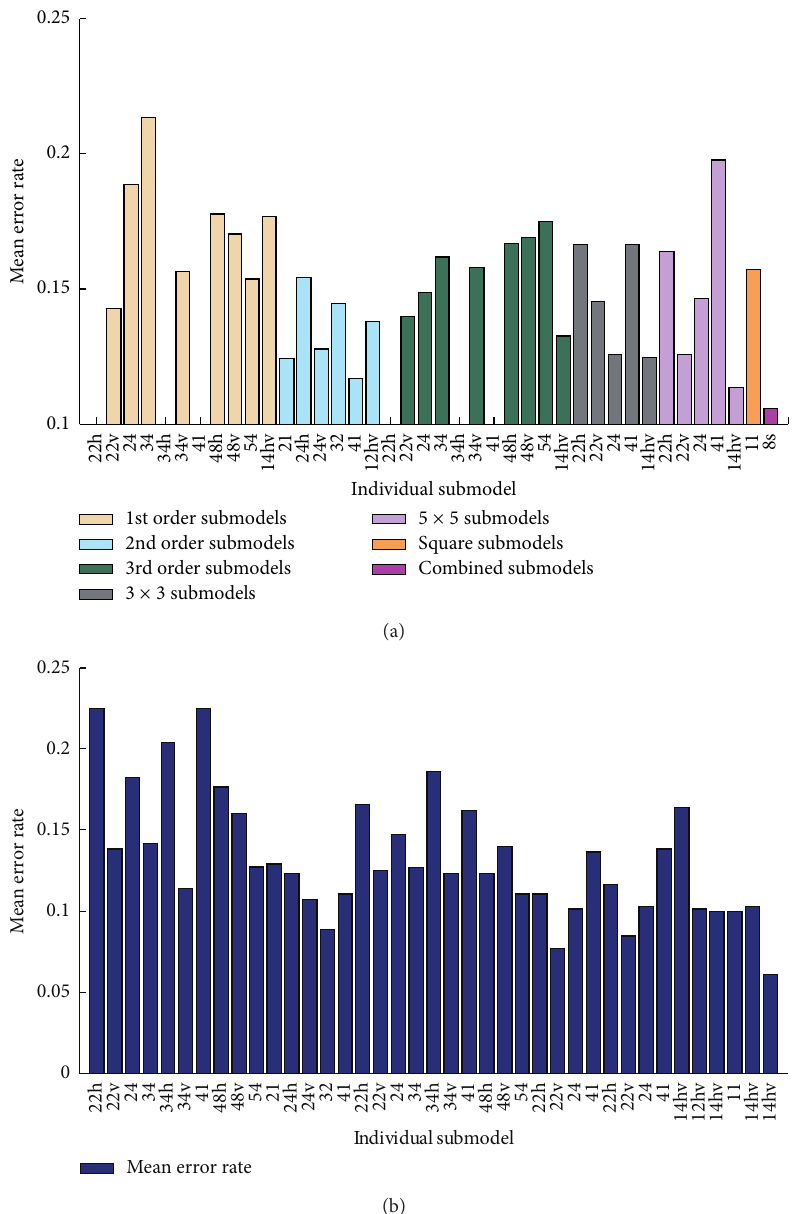
Figure 2: The mean errors of individual submodels for (a) Columbia dataset, (b) CASIA V2 dataset. Blank bars represent that the mean errors of the models are not